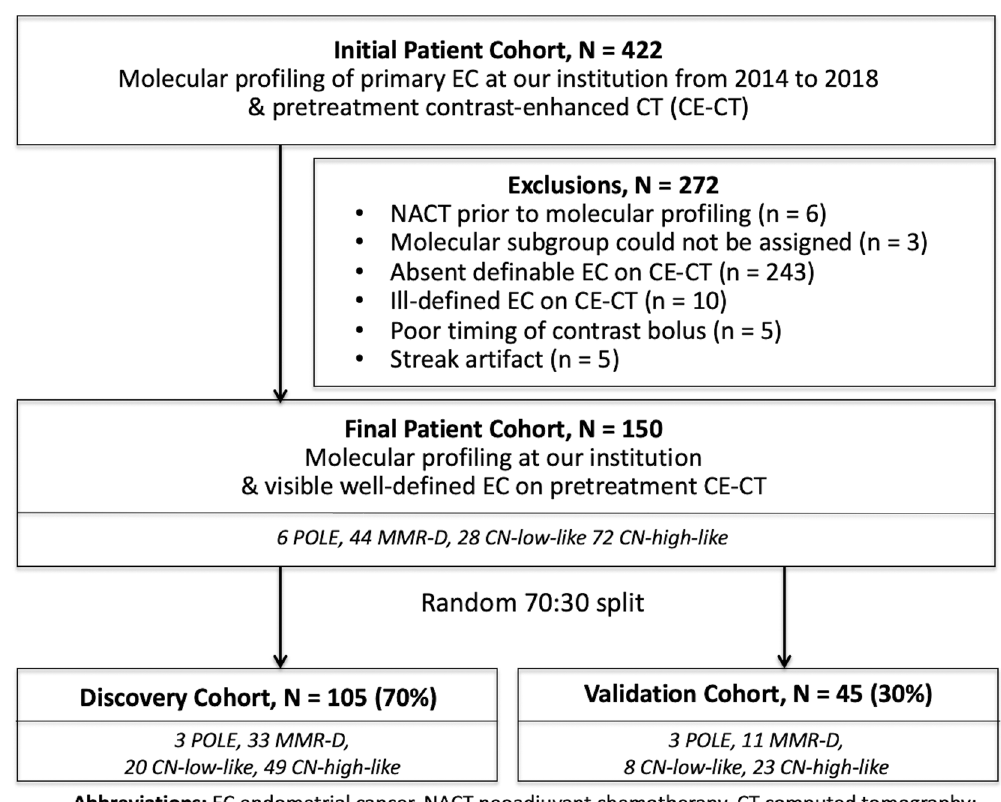
Figure 2. Flow chart illustrating the patient selection criteria. EC endometrial cancer, CE-CT contrast- enhanced computed tomography, NACT neoadjuvant chemotherapy, POLE polymerase epsilon, MMR-D DNA mismatch repair-deficient, CN copy